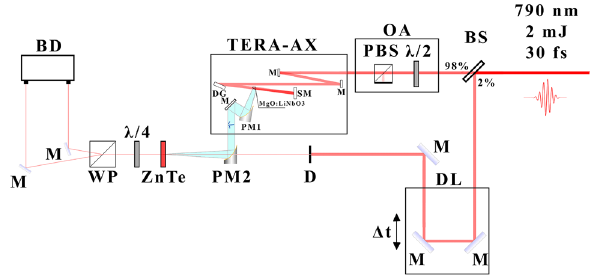
Figure 5. Schematic diagram of the experimental setup. Standard electro optical scheme for detecting the THz field using a 1 mm thick ZnTe crystal. The THz radiation source is a lithium niobate crystal, pumped by pulsed laser radiation. BS beamsplitter, OA optical attenuator, PBS poralizing beamsplitter, (cid:31) /2 half-wavelength plate, TERA-AX terahertz generator, M mirrors, DG diffraction grating, SM spherical mirror, PM parabolic mirror, DL delay line, D diaphragm, ZnTe 1 mm thick zinc telluride crystall, (cid:31) /4 quarter-wavelength plate, WP wollaston prism, BD balanced